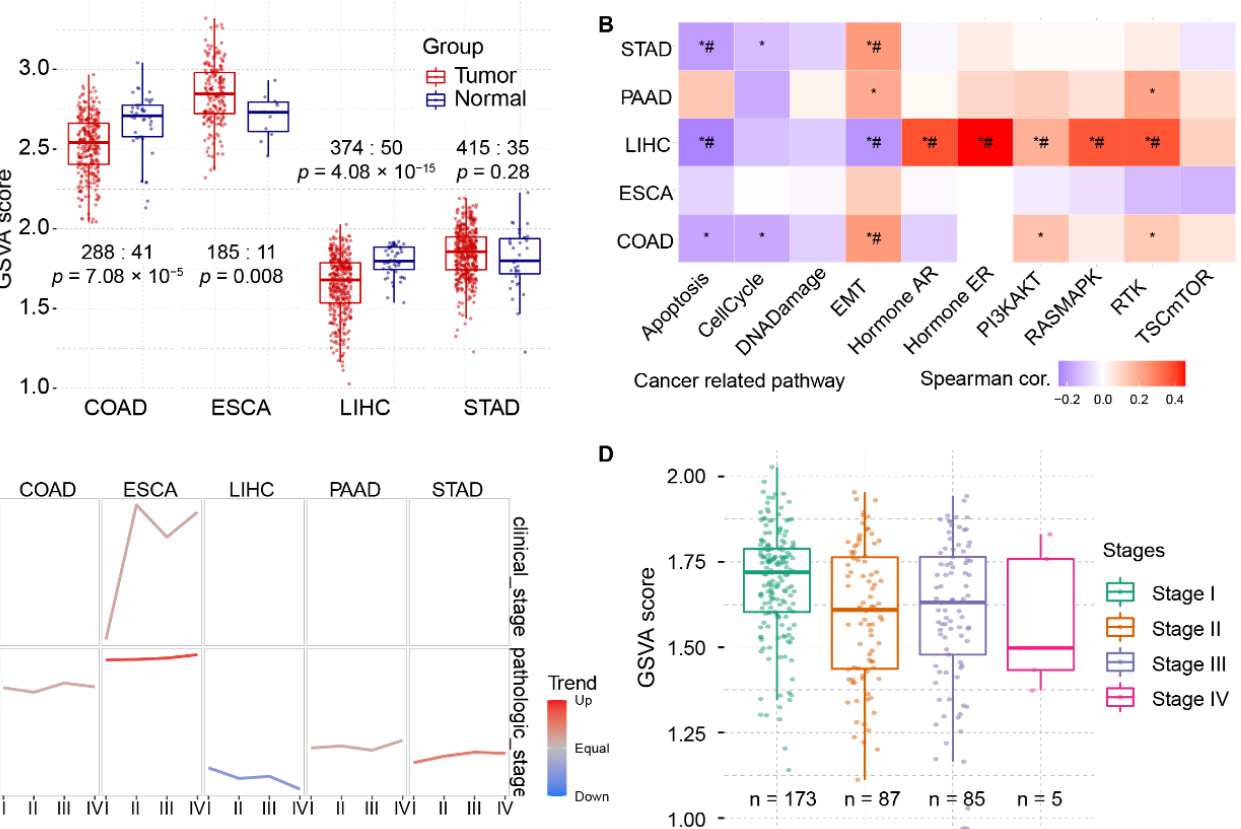
Figure 3. Gene set variation analysis (GSVA) of the selected PRGs with clinical value between different pathologic stages in LIHC and other digestive system cancers. ( A ) Original GSVA score between tumor and paracancerous tissues. ( B ) GSVA-altered pathways in different cancer types from digestive system. ( C ) GSVA trend analysis of 61 polarity-related genes across digestive system cancers. ( D ) Detailed trend analysis in LIHC cohort showed difference between pathological stages. *, p < 0.05; #, FDR < 0.05.